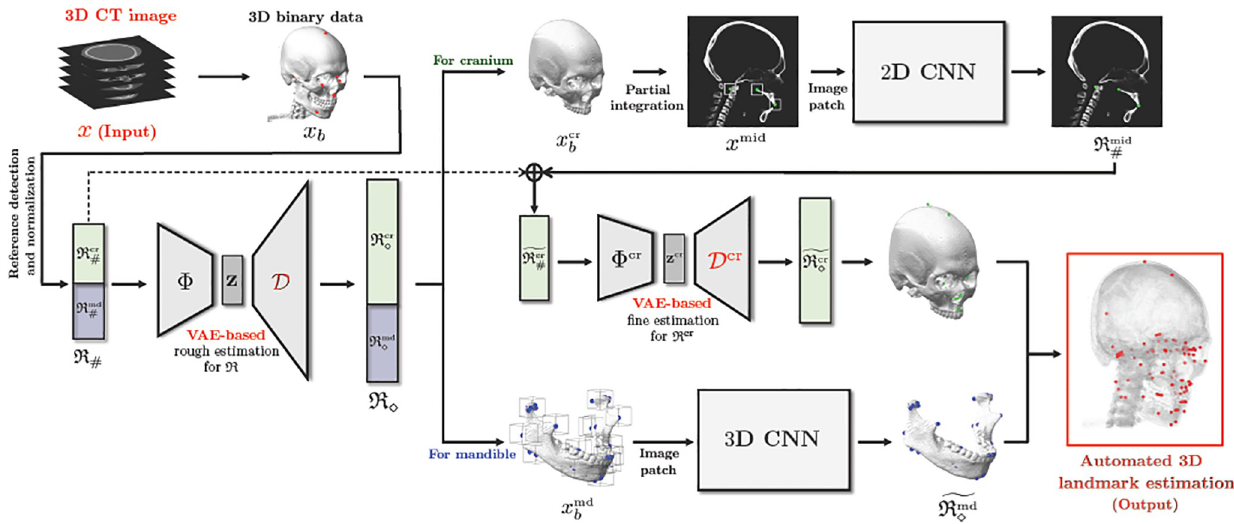
Fig 2. Schematic diagram of the proposed method for the 3D landmark annotation